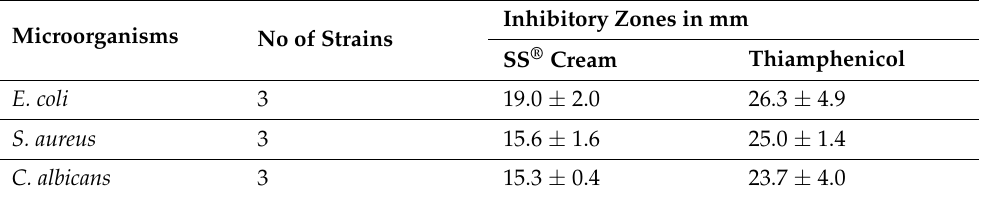
Table 1. In vitro antimicrobial activity of SS ® cream on Escherichia coli , Staphylococcus aureus , and Candida albicans